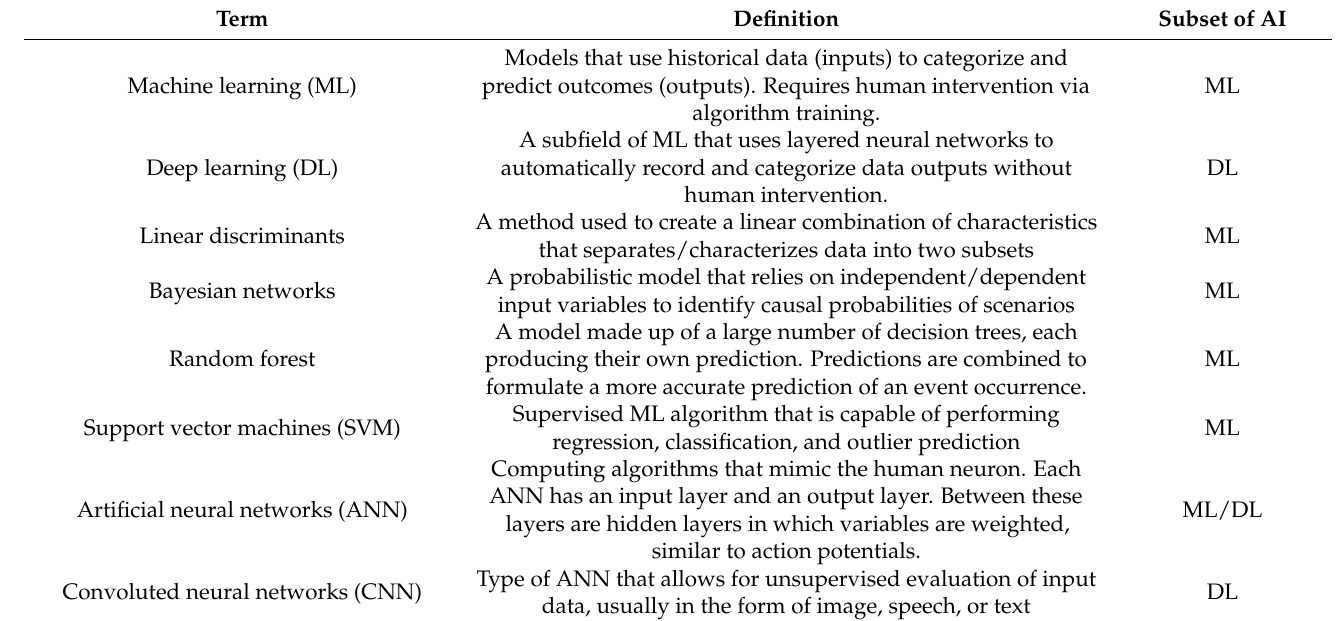
Table 2. Artificial intelligence (AI)